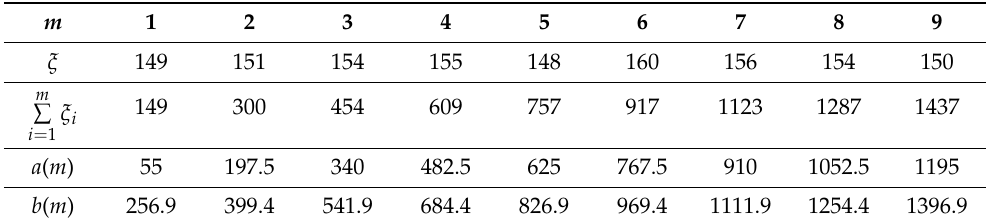
Table 1. Values of the variables used in the sequential decision-making procedure regarding the deviations of the generalized